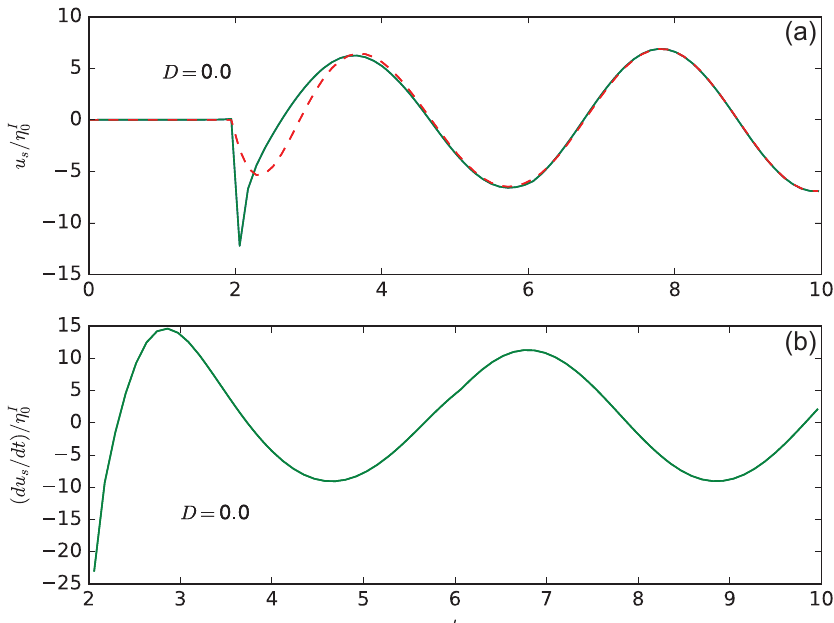
Figure 5. Panel (a) is the shoreline velocity u s normalised to the amplitude of the incident wave as a function of t (Model 1). The frequency of the incident wave is (cid:60) ω 1 . The continuous green curve is the shoreline velocity corresponding to incident wave η = η I √ √ D + 1 ))θ(t + (x − 1 )/ D + 1 ) . The red dashed curve is the same for the incident wave that has been smoothed by multiplying it by 1 )/ √ D + 1 ) . Panel (b) is the time derivative of the shoreline velocity for the smoothed incident tanh (t + (x − 1 )/